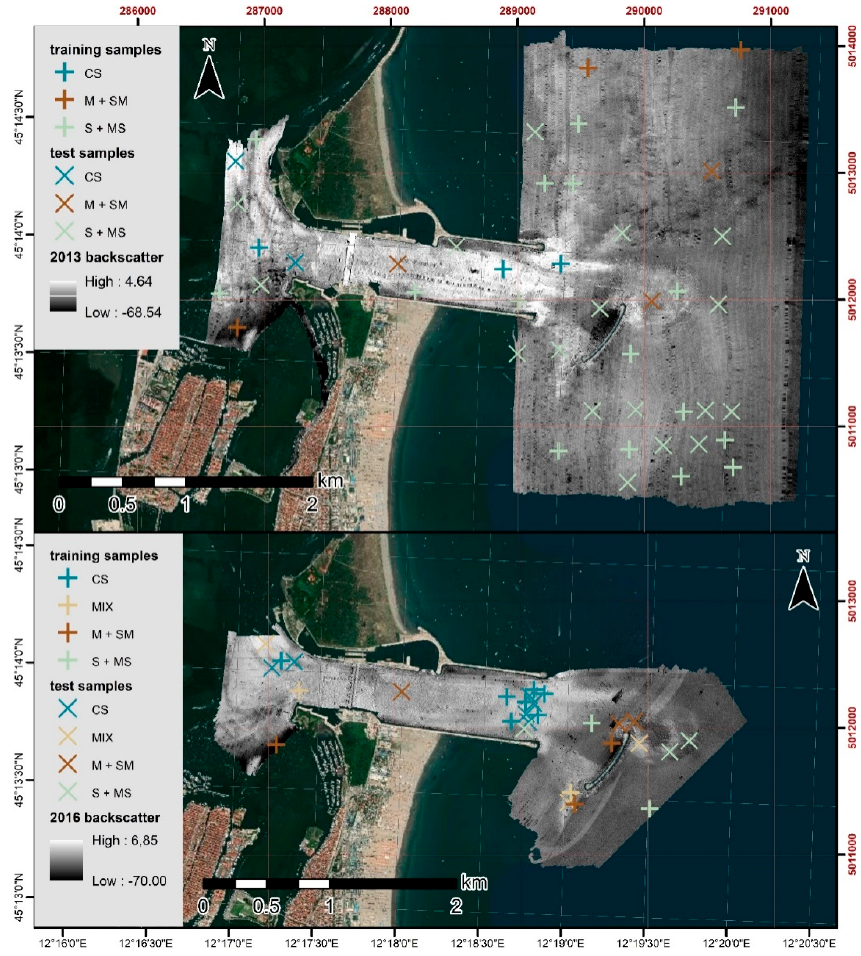
Figure 4. Locations of ground truth training and validation samples with class separation on the backscatter layers of Chioggia 2013 and 2016. CS—coarse sediment; M + SM—mud and sandy mud; S + MS—sand and muddy sand; and MIX—mixed sediment.